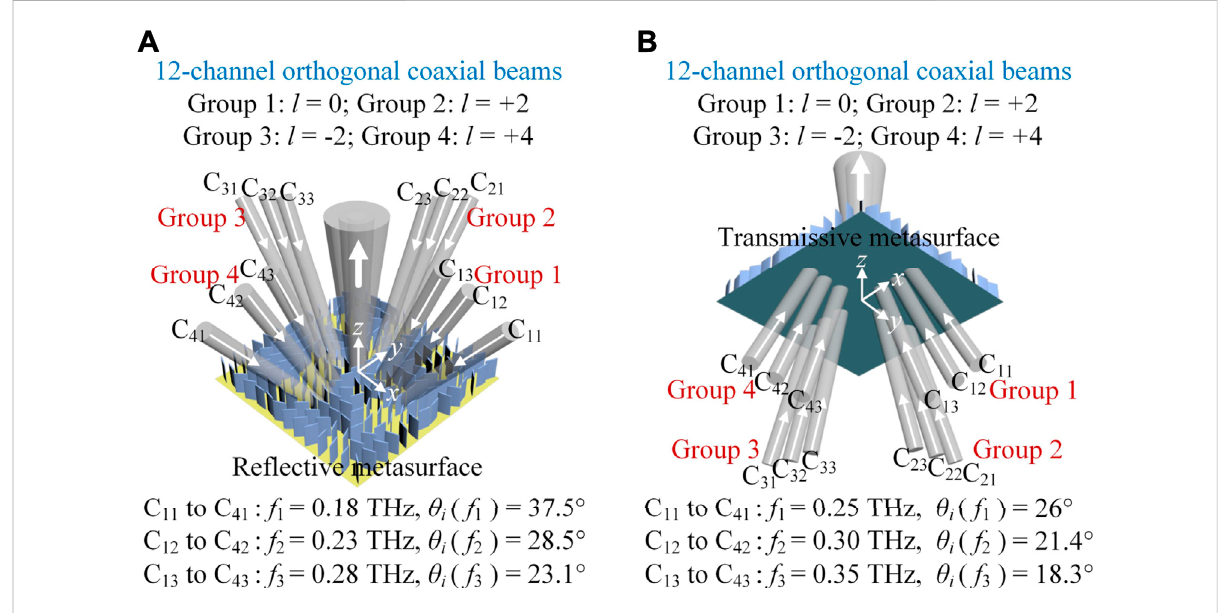
FIGURE 5 The schematic diagram for two-dimensional12-channelmultiplexing combing with OAM andfrequency realized bythedesignedmetasurface (A) Re fl ective metasurface (B) Transmissive